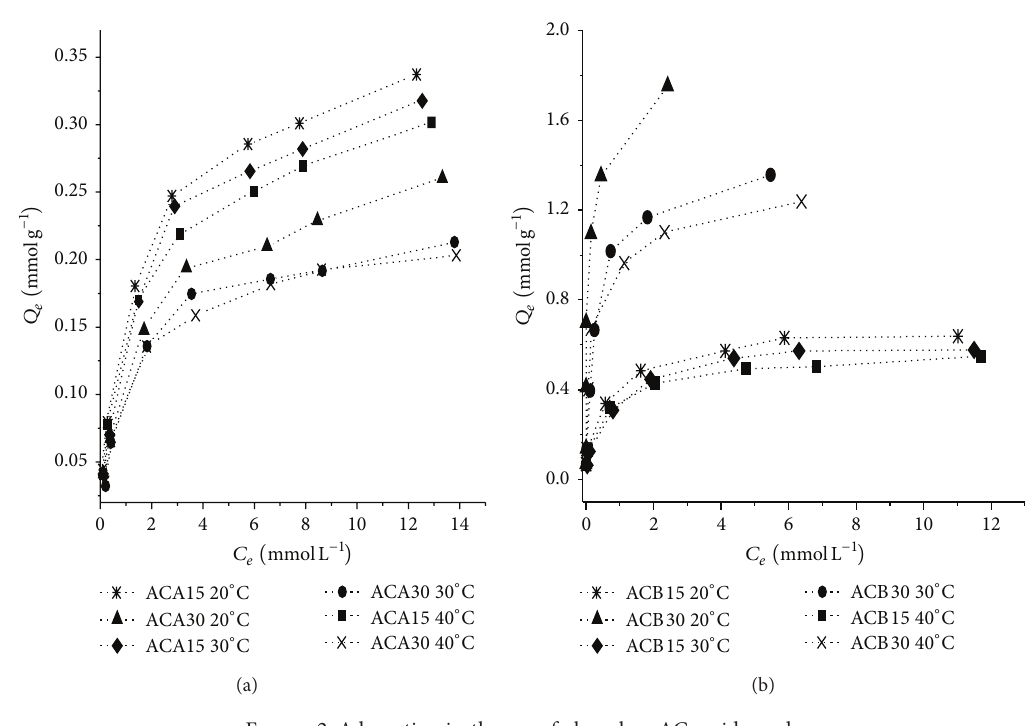
Figure 2: Adsorption isotherms of phenol on ACs evidenced.